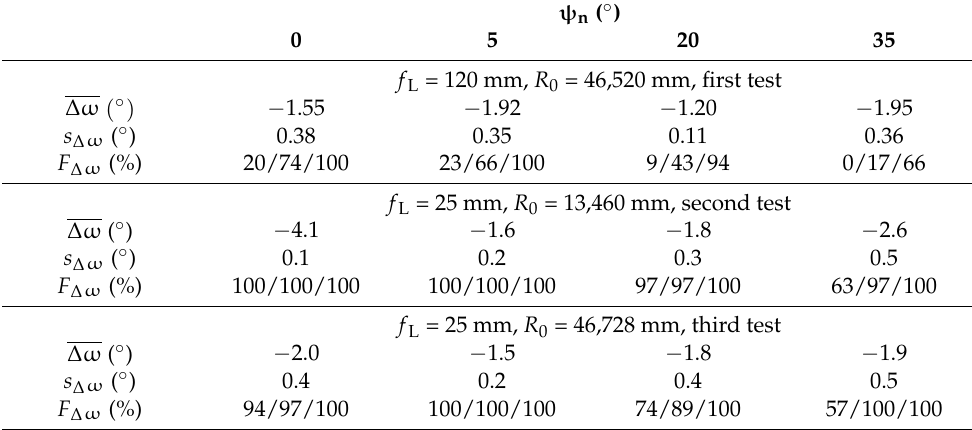
Table 3. Summary of the azimuth measurement results.